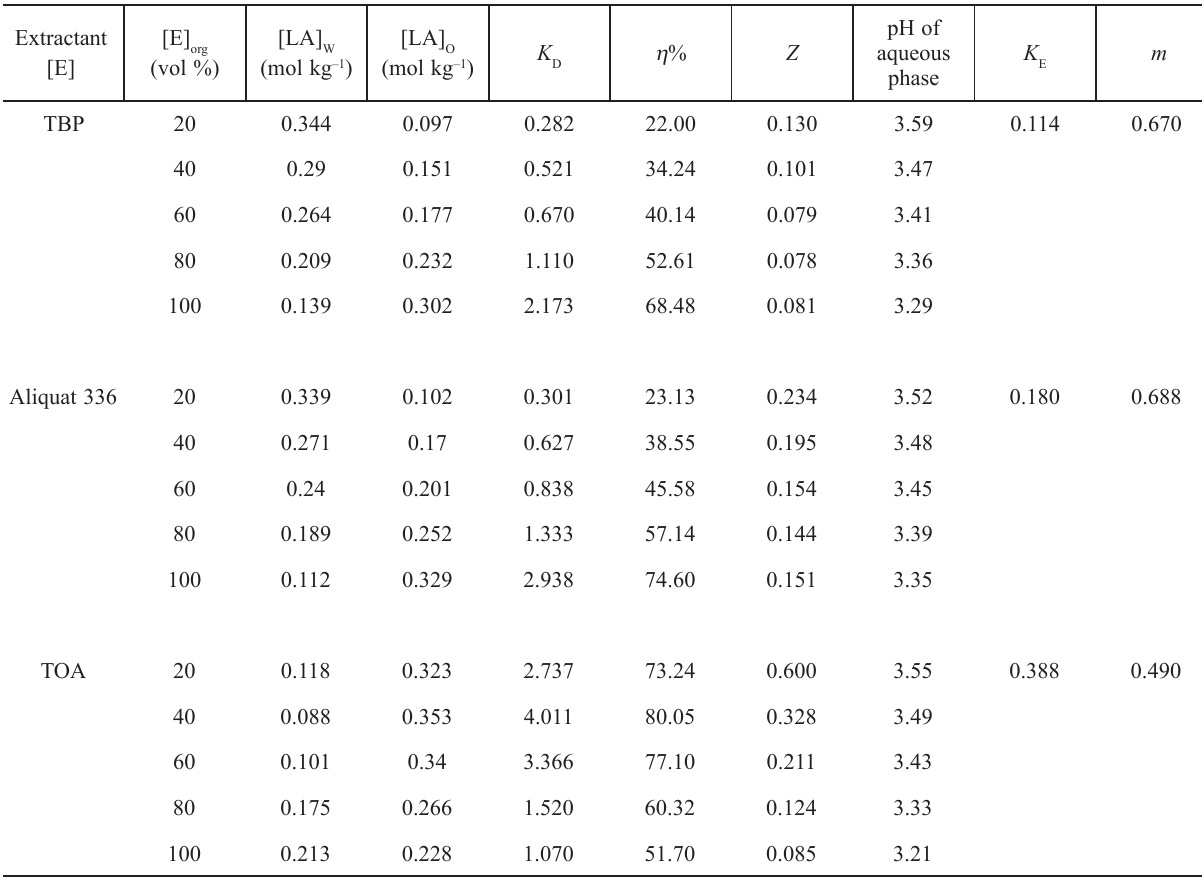
Table 2 – Various parameters of reactive separation of levulinic acid of 0.441 mol kg –1 concentration from aqueous solution using TOA, TBP, and Aliquat 336 with i-octanol at 298.15 ± K